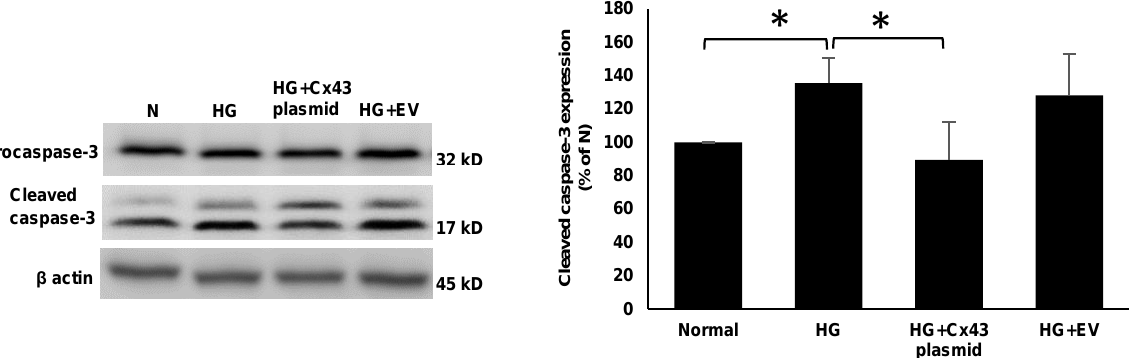
Figure 2. Cx43 upregulation reduces Bax expression. Bax expression was significantly increased in cells grown in HG condition compared to those grown in N medium. In cells grown in HG and transfected with Cx43 plasmid, Bax expression was significantly reduced compared to those grown in HG medium. Bar graph shows cumulative data obtained from Figure 3 six experiments. Data are presented as mean ± SD, * p < 0.05; n = 6.